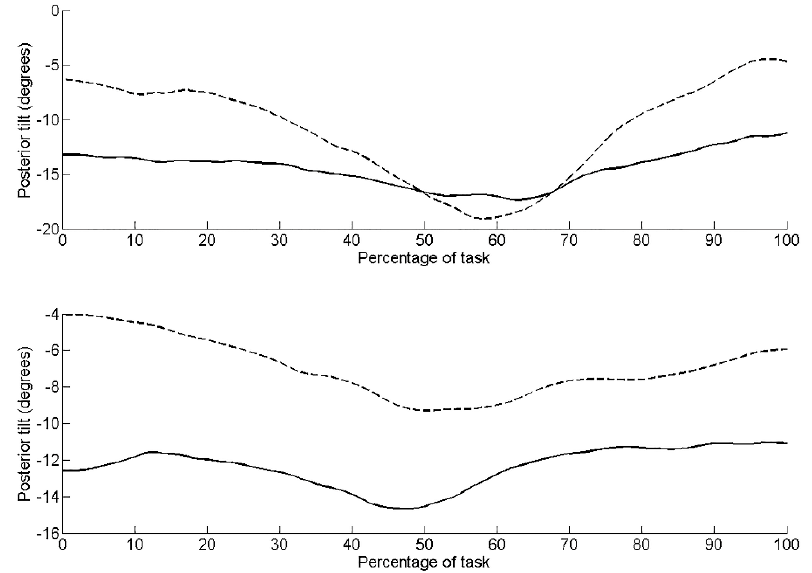
Figure 2. Posterior tilt of the pelvis during the seated hip flexion task for the left side (upper graph) and right side (lower graph). Dashed line represents pre-intervention, solid line represents post- intervention. Table 2. Average root mean squared error (RMS error) between the three repeated trials during the seated hip flexion task for pre- and post-intervention.